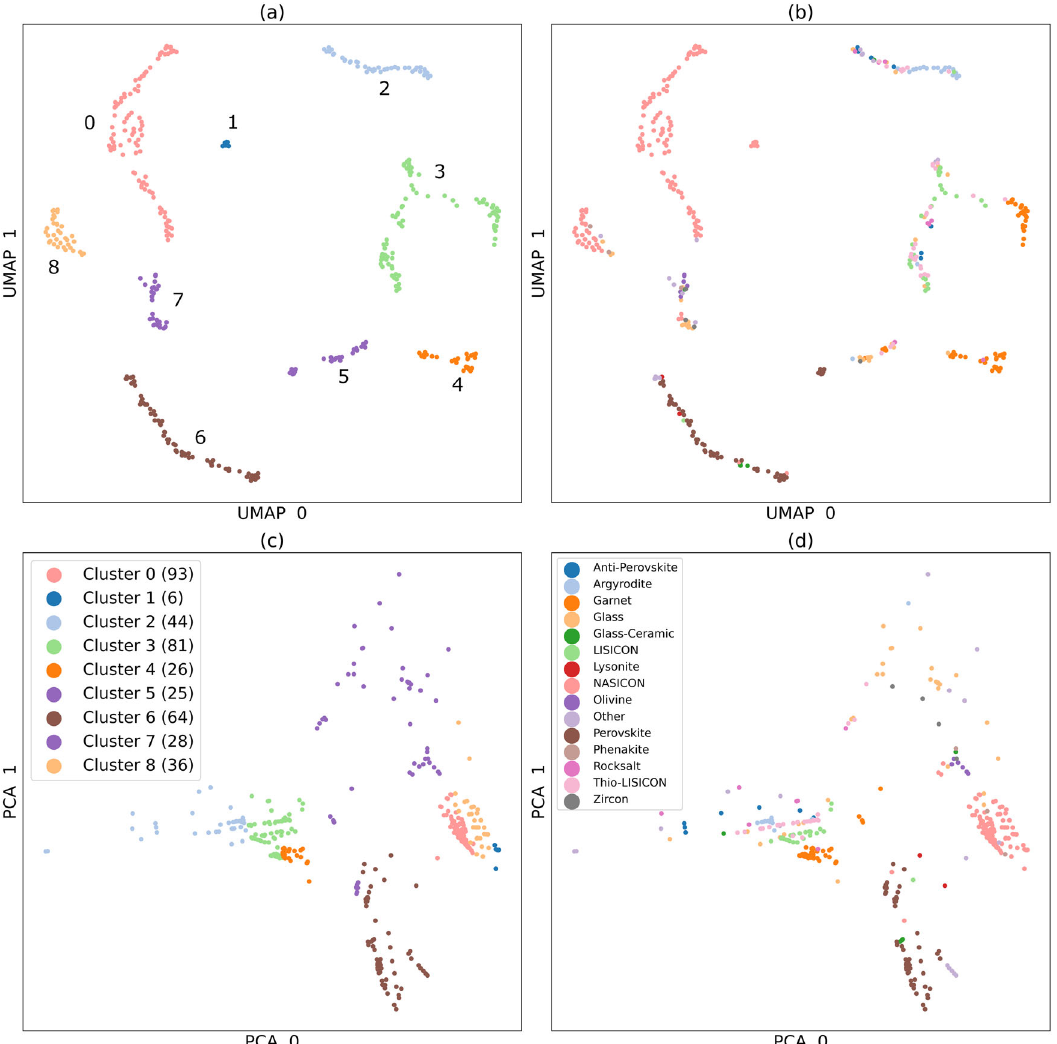
Fig. 4 Embeddings of the 403 unique room temperature solid state electrolytes compositional data. a , b Show the coordinates obtained from the UMAP embedding algorithm, whilst ( c ) and ( d ) arise from PCA. The cluster labels in ( a ) and ( c ) are obtained from the DBSCAN clustering algorithm applied to the UMAP embedded points in ( a ), with the number of materials in each cluster given in brackets. Cluster labels in ( b ) and ( d ) were assigned from expert review to classify each material under a structural